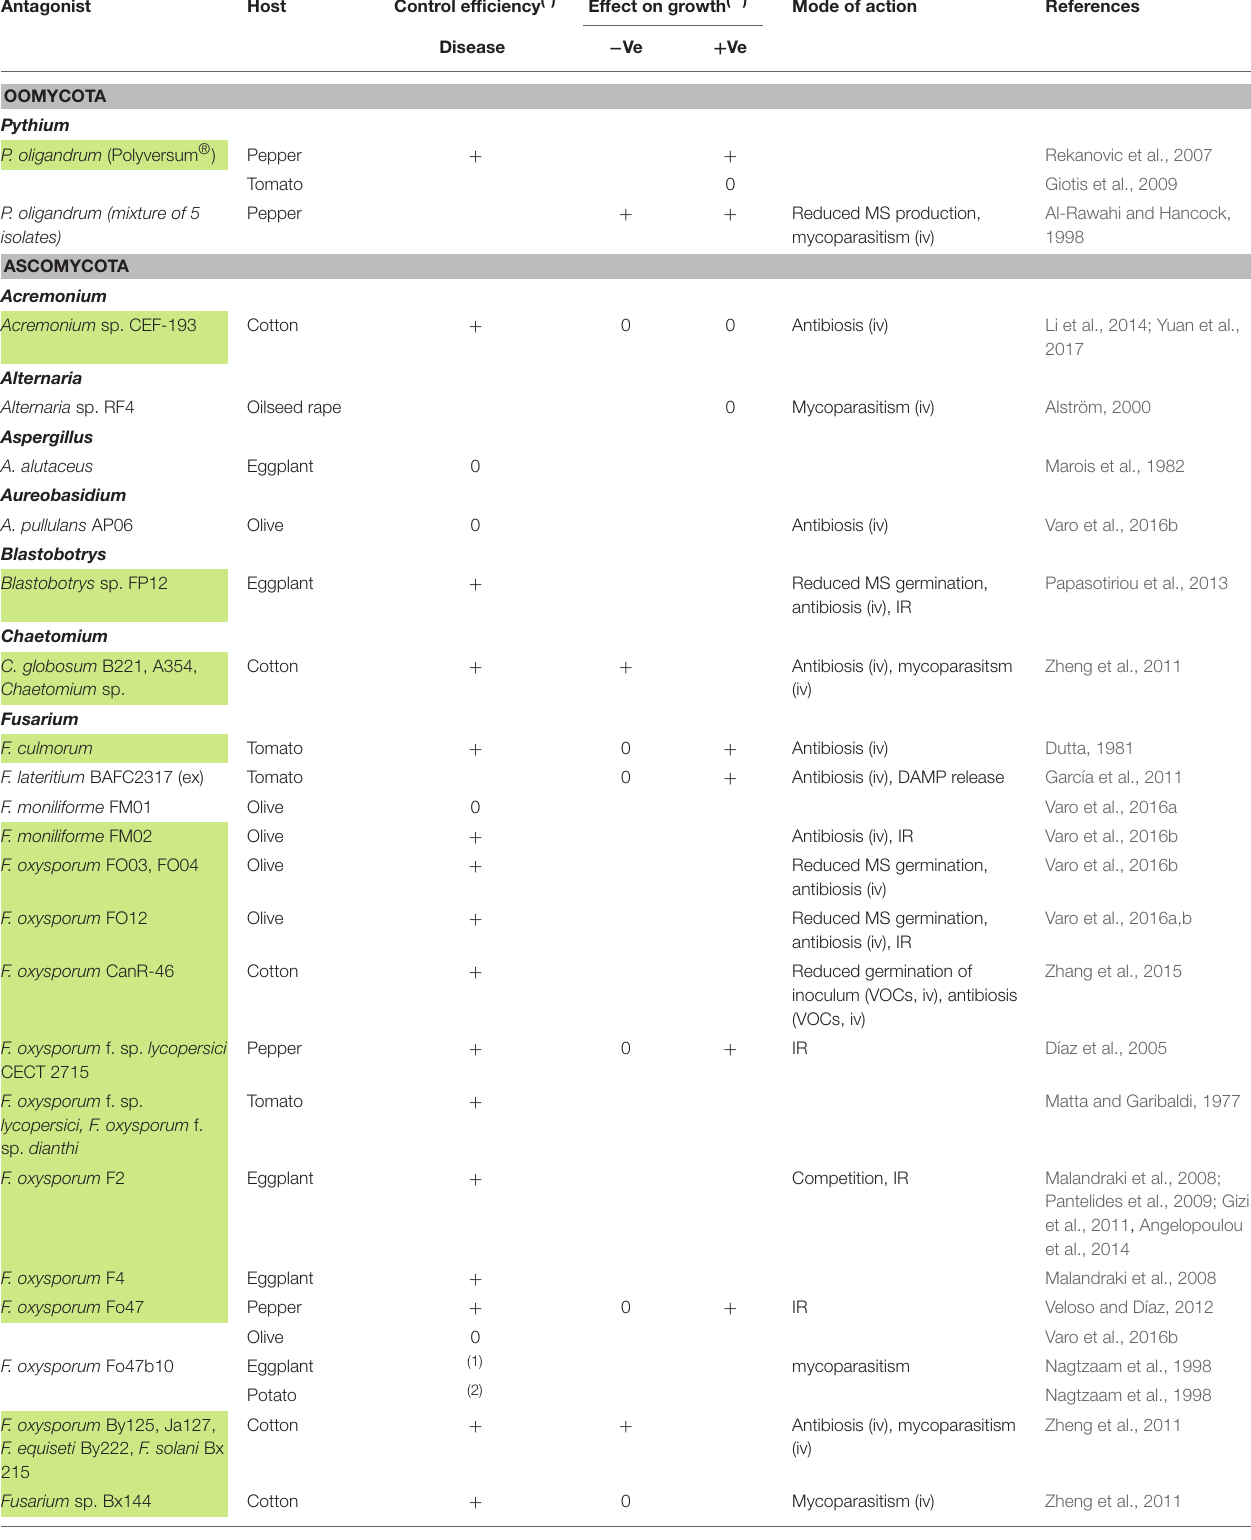
TABLE 3 | Fungal and oomycete isolates with potential biocontrol activity against Verticillium in different host